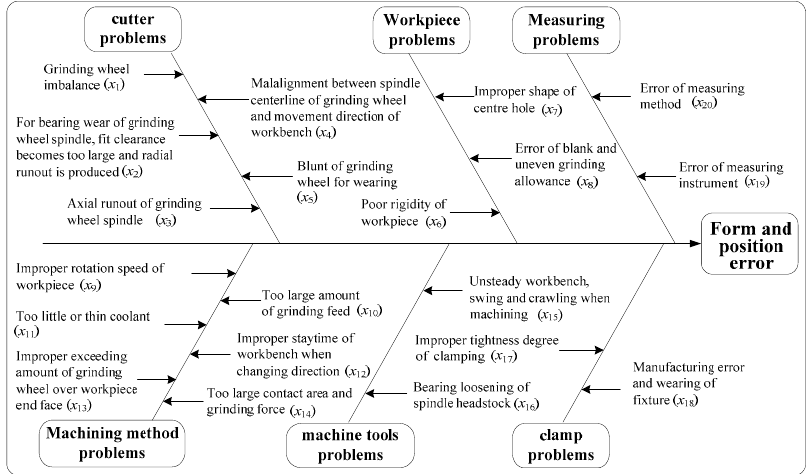
Figure 5. Fishbone diagram of relationship between abnormal patterns and assignable causes.